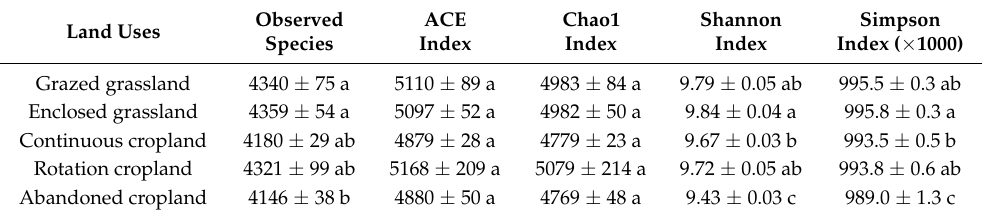
Table 1. The averaged bacterial diversity for each sample site ( n = 4). Different letters indicate the significance between land-use patterns.